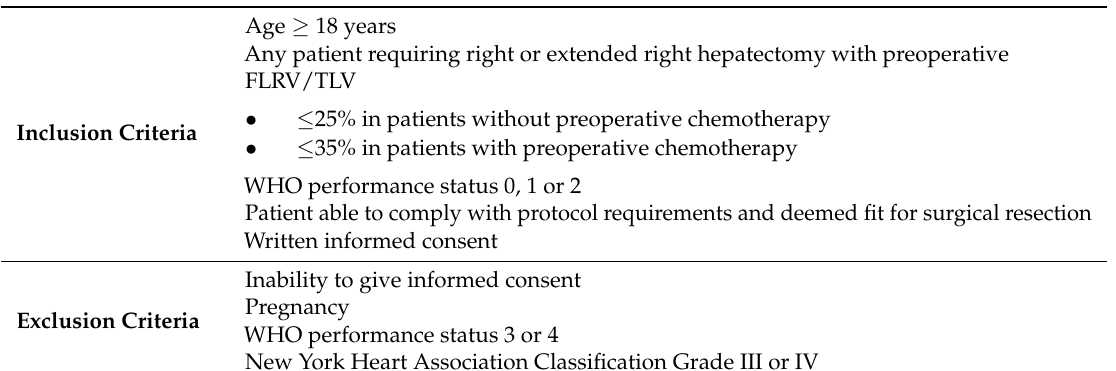
Table 1. Selection